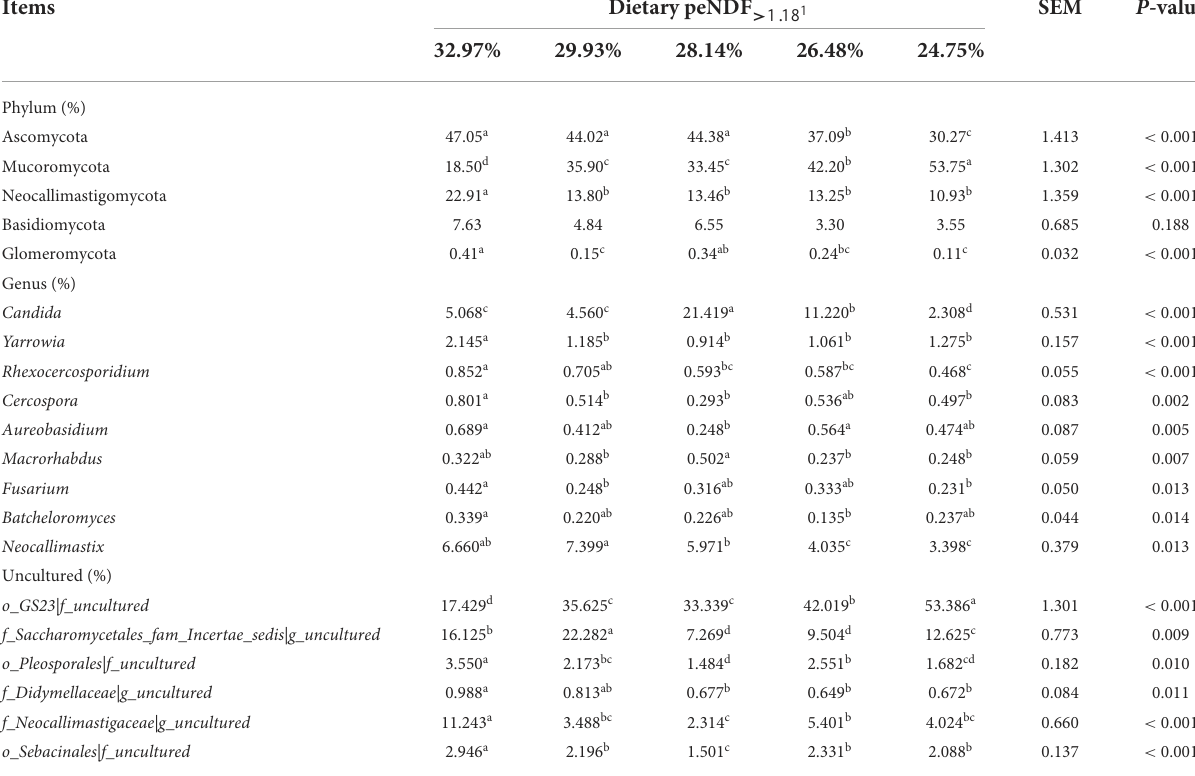
TABLE 8 Effects of different contents of peNDF > 1.18 in diets on rumen fungi abundance in